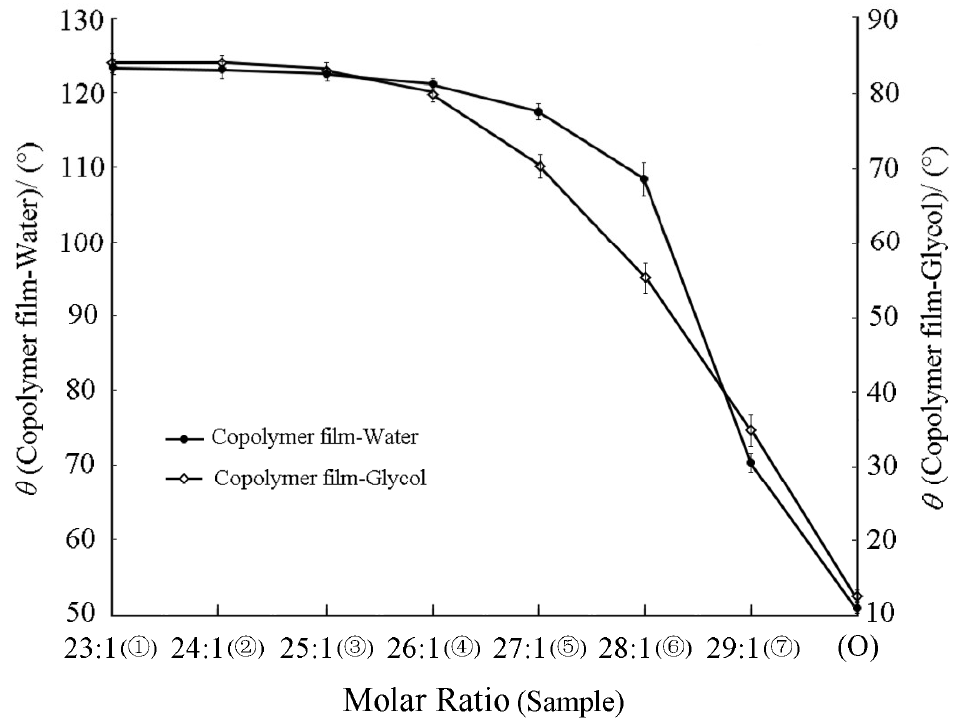
Figure 5. Contact angle of water and ethylene glycol on coating prepolymer film with different amounts of fluorine monomers (Samples with different molar ratios of epoxy group to DFHMA).